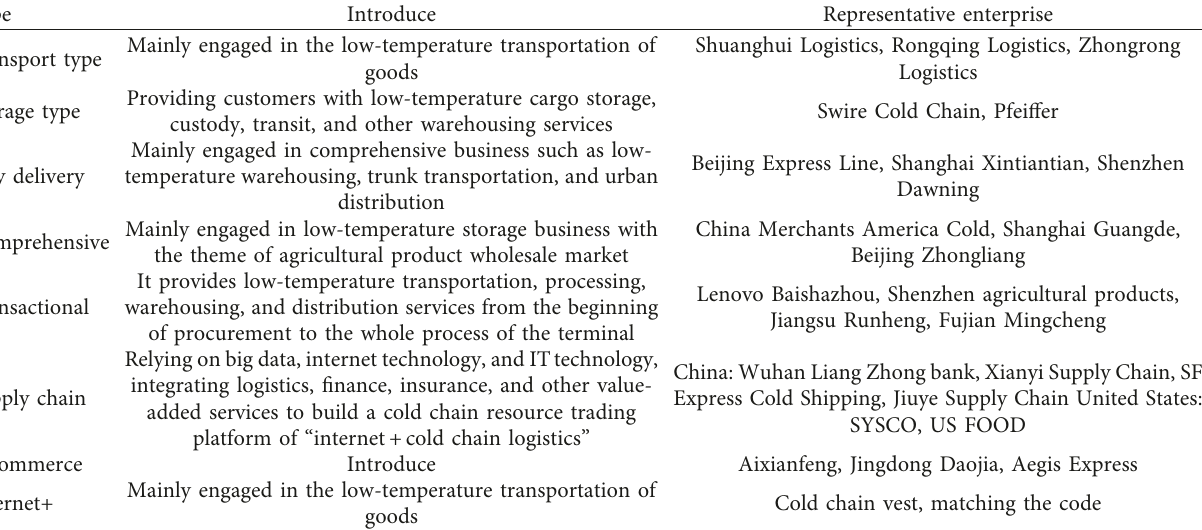
Figure 2: Three stages of e-commerce Table 1: Common e-commerce fresh food cold chain service models.